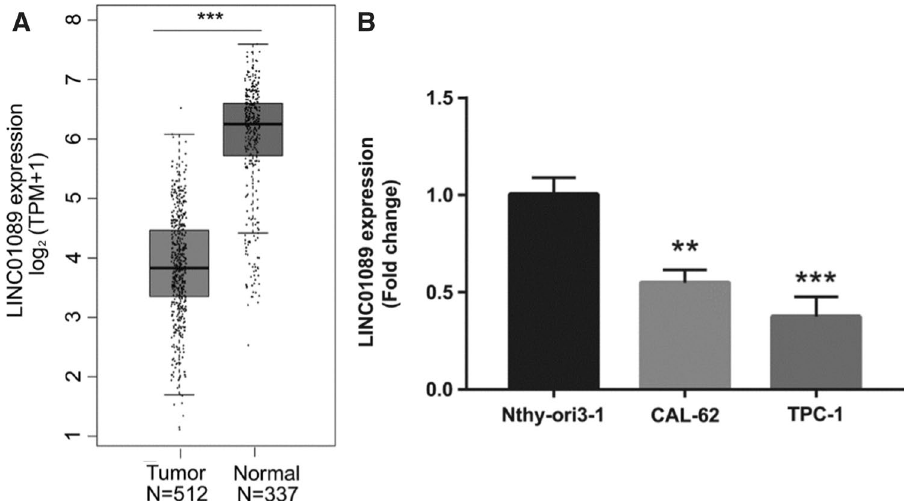
Fig. 1 LINC01089 expression was low in thyroid cancer tissues and cells. A LINC01089 expression was low in thyroid cancer tissues, as deter- mined by GEPIA